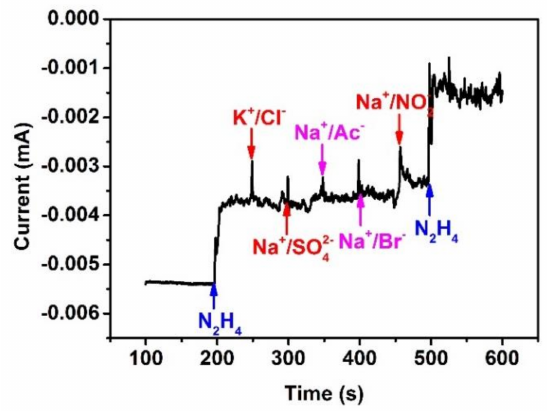
Figure 8. The response to the addition of hydrazine as well as